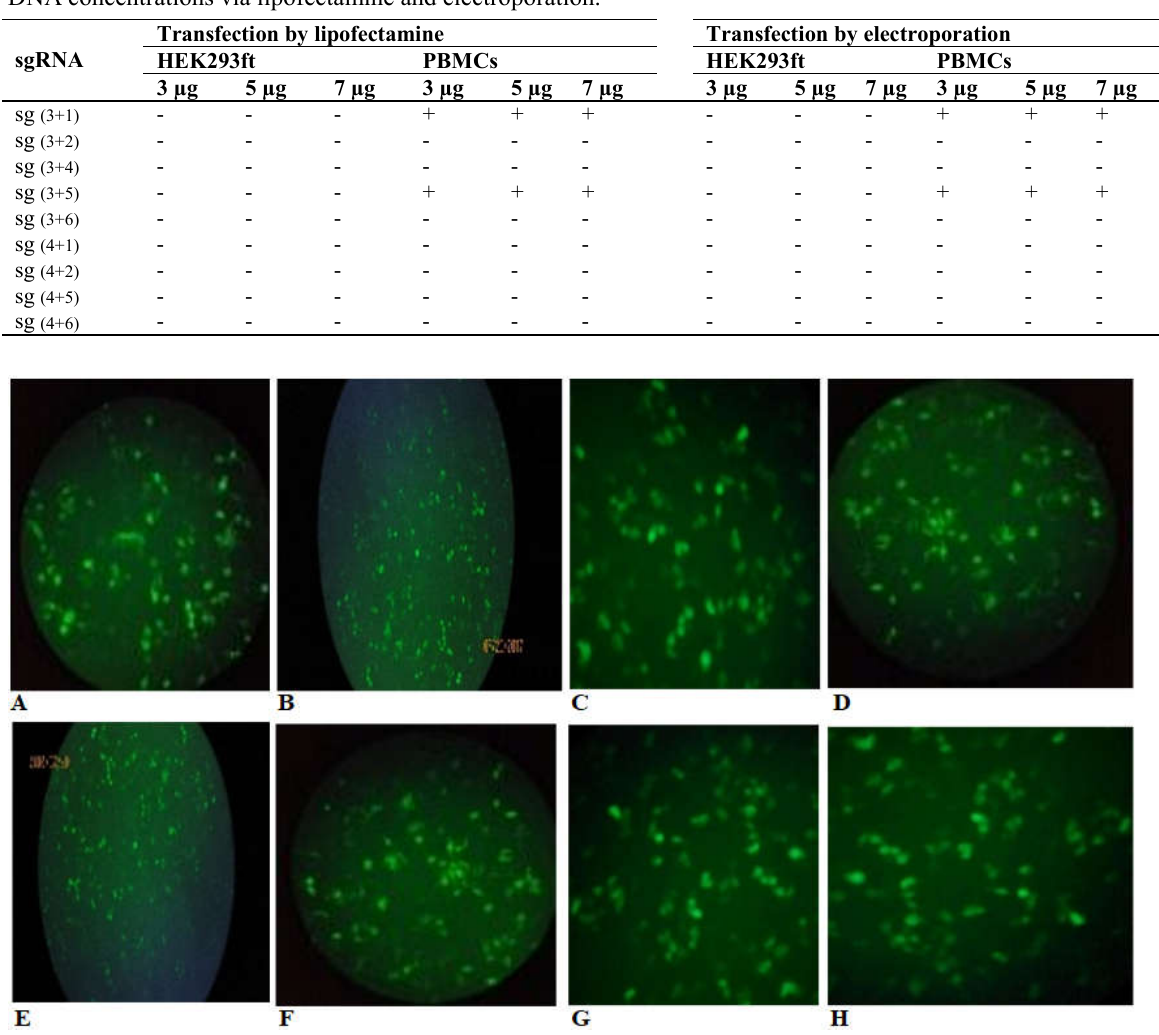
Table 4. Comparison of the existence of cleavage after transfection of HEK293ft and PBMCs cells by different DNA concentrations via lipofectamine and electroporation.